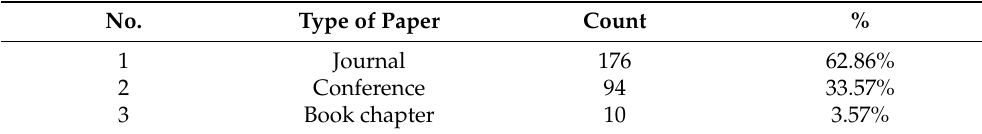
Table 3. Types of